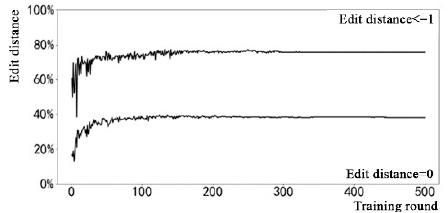
Figure 22. Expert-driven learning with a factor of 1 /